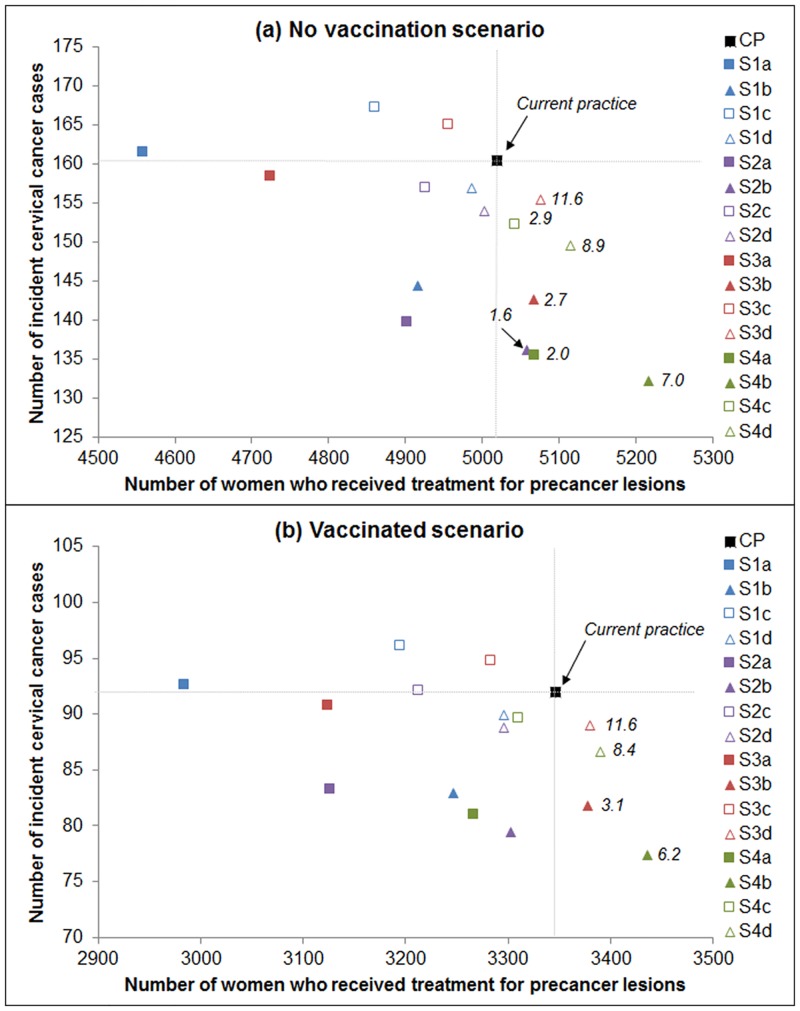
Comparison of the number of cervical cancer cases with the number of women who received treatment for precancer predicted for each strategy.Numbers shown on the chart represent the number of additional treatments required per cancer case prevented compared to current practice. The number of additional treatments required per cancer case prevented ratio was calculated for each strategy with a higher number precancer treatments and lower number of cervical cancer cases than CP. The calculated ratio is display in the figure on side of the marker that represents the strategy.